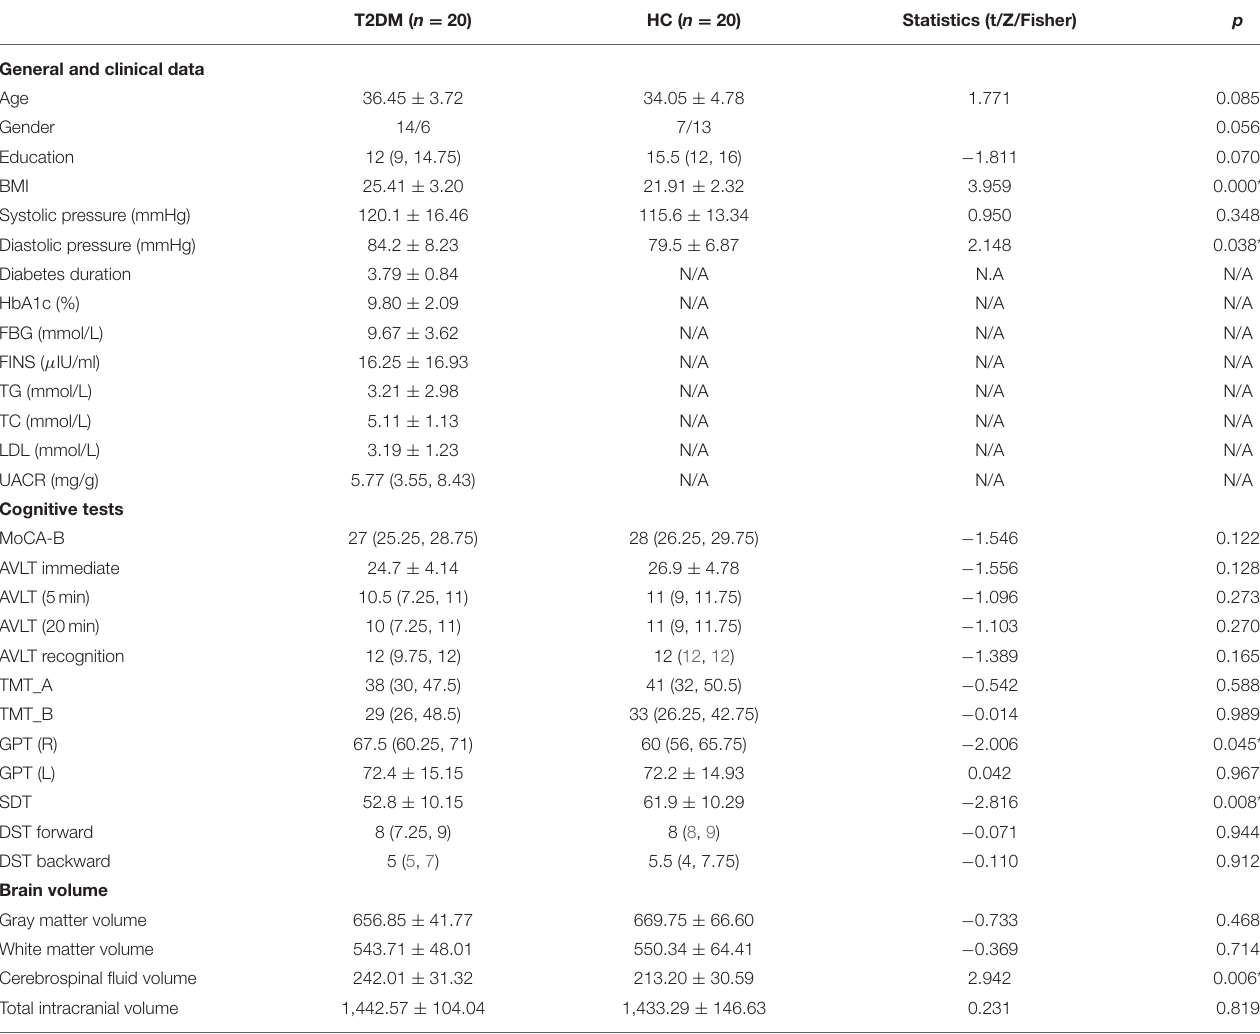
TABLE 1 | Demographic and clinical data of all participants. T2DM ( n = 20) HC ( n = 20) Statistics (t/Z/Fisher)